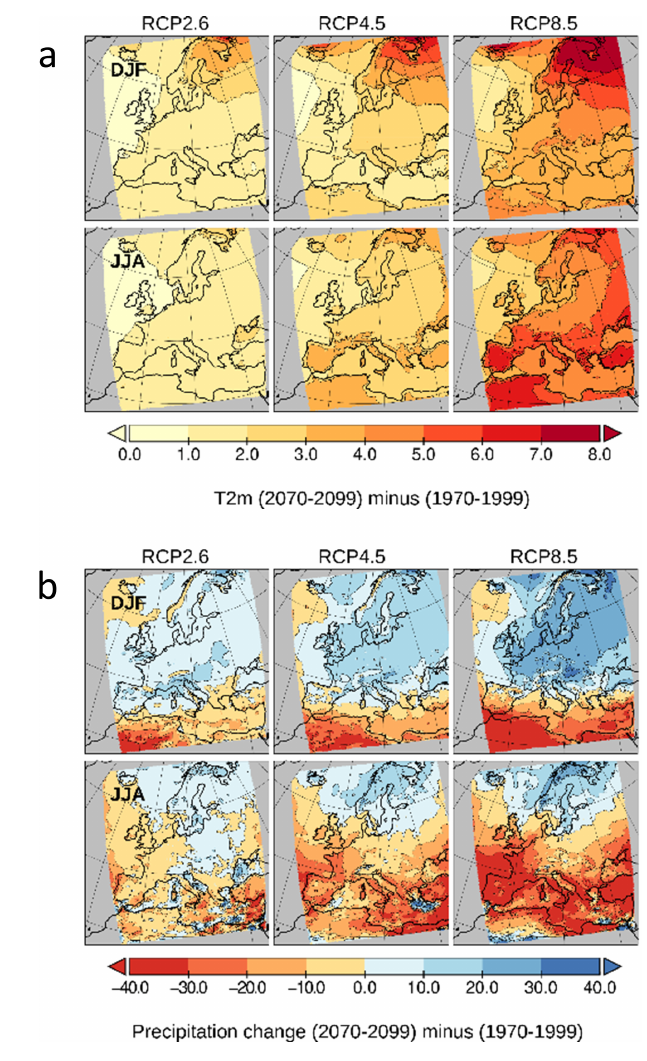
Figure 26. (a) Ensemble mean 2m air temperature change (degrees Celsius) between 1970–1999 and 2070–2099 for winter (December through February; upper panels) and summer (June through August; lower panels) under RCP2.6, RCP4.5, and RCP8.5. Panel (b) is the same as panel (a) but for precipitation change (percent). In total, eight different dynamically downscaled Earth system model (ESM) simulations are used. Data source: Gröger et al.,